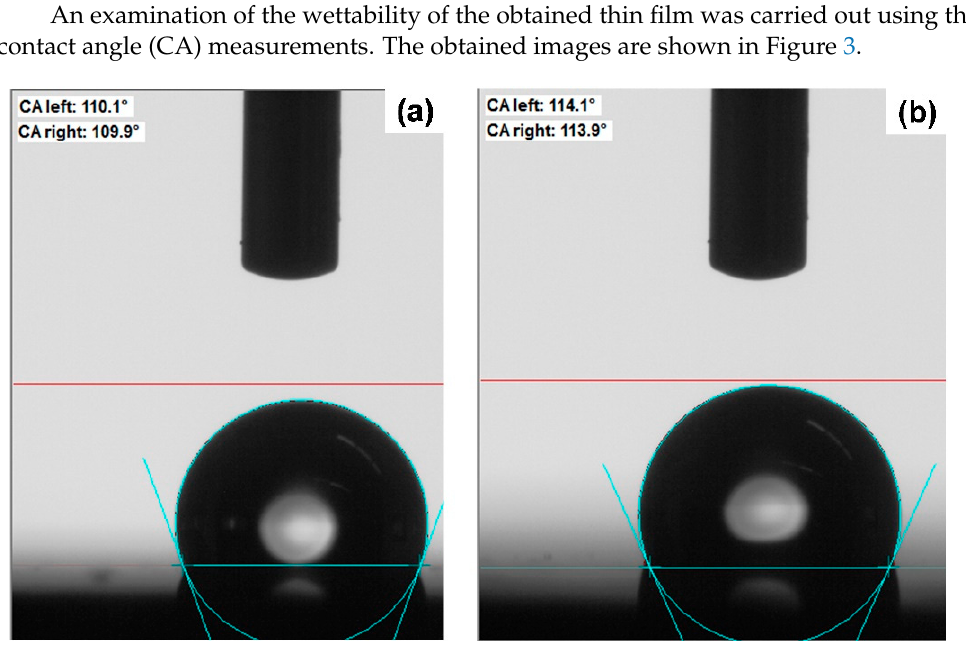
Figure 3. The CA of ( a ) original copper and ( b ) CNTs-deposited